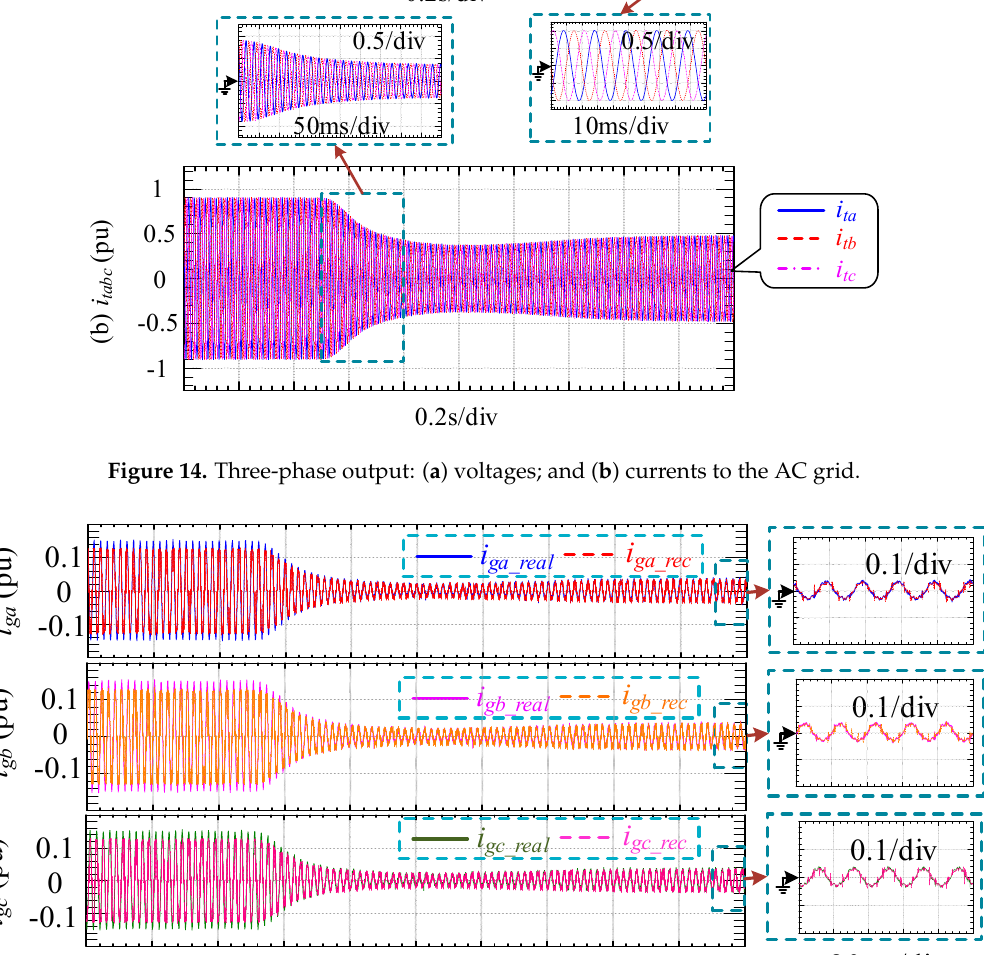
Figure 15. Real and reconstructed three-phase GSC AC currents.